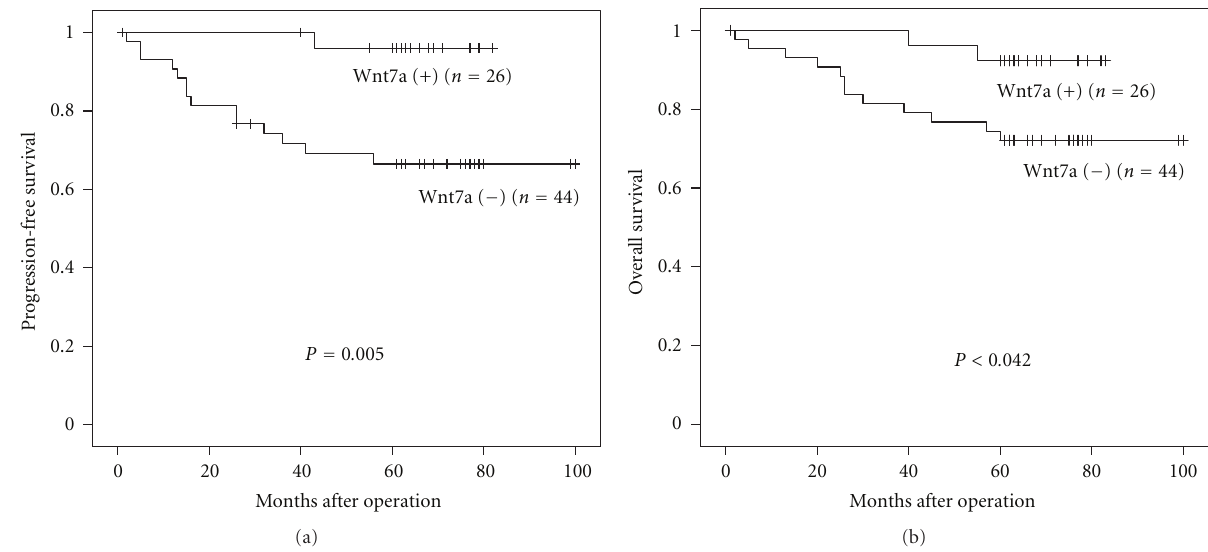
Figure 3: (a) Kaplan-Meier curves for PFS of endometrial carcinoma patients according to negative and positive expression of Wnt7a (log- rank analysis). (b) Kaplan-Meier curves for OS of endometrial carcinoma patients according to negative and positive expression of Wnt7a (log-rank analysis).